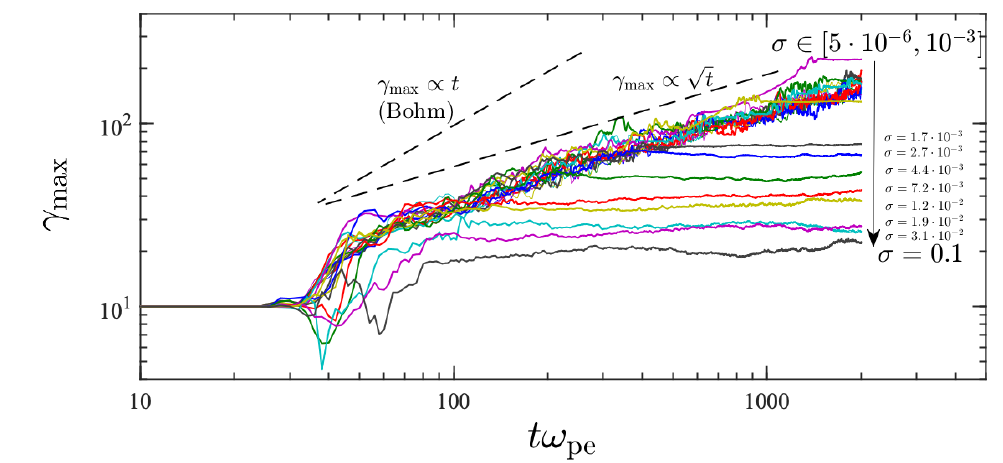
Figure 9. Temporal evolution of the maximal Lorentz factor of the particle distribution in different simulations with increasing magnetization (lines with different colors). The dashed lines indicate, for reference, the γ max ∝ t (Bohm regime), and γ max ∝ From Ref.